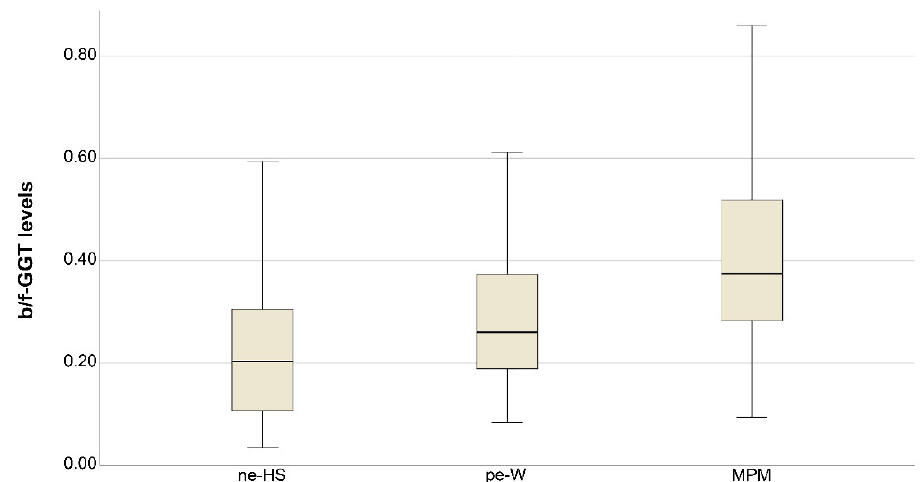
Figure 1. Graph showing the big/free-GGT ratio levels (b/f GGT) in the group of non-exposed subjects (ne-HS), previously exposed workers (pe-W), and patients affected by malignant mesothelioma (MPM). Box represents the first and the third quartile; the black line corresponds to the median value; the whiskers are 1st and 99 th percentile.